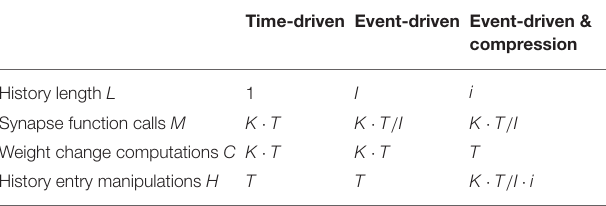
TABLE 1 | Comparison of synapse update schemes. Time-driven Event-driven Event-driven &